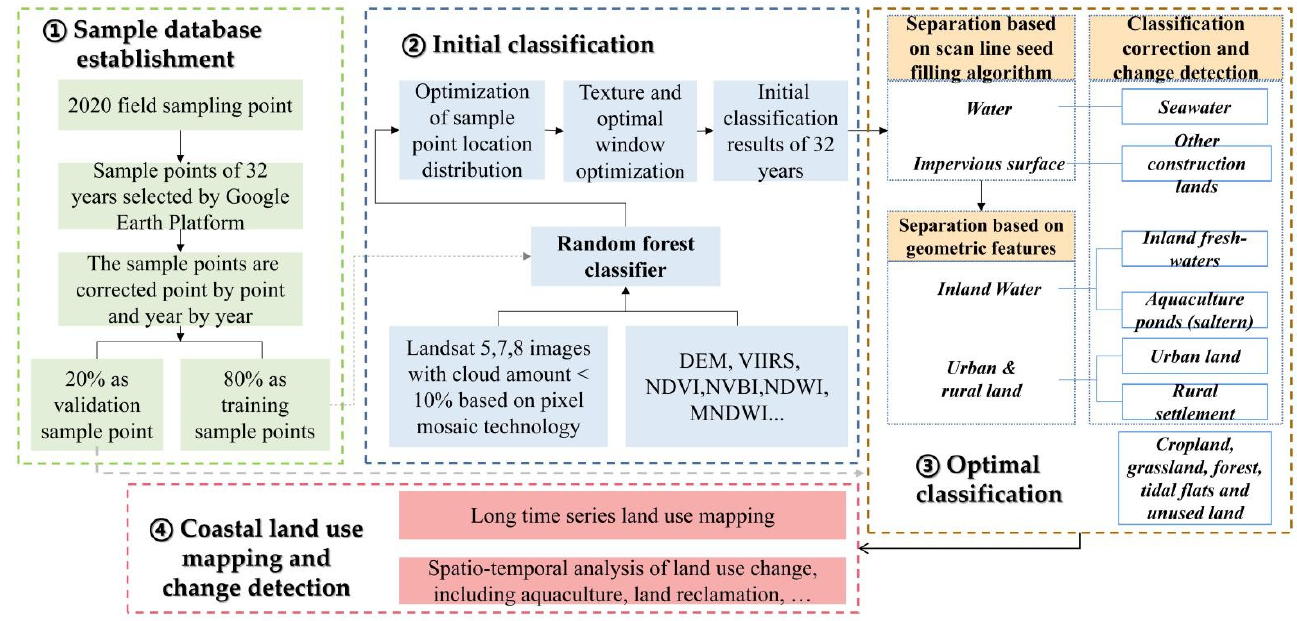
Figure 2. Flowchart of the framework for the long time-series mapping and change detection of coastal zone land use based on GEE and multi-source data fusion.